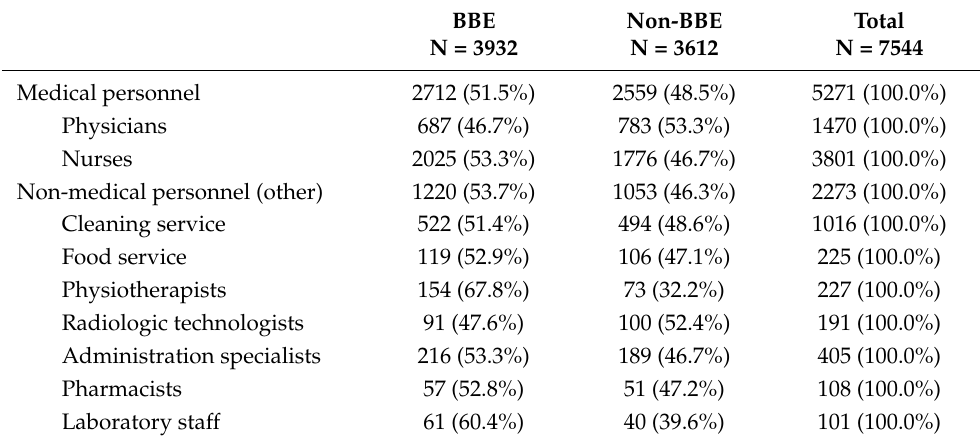
Table 1. The frequency of adherence to the BBE concept, depending on the